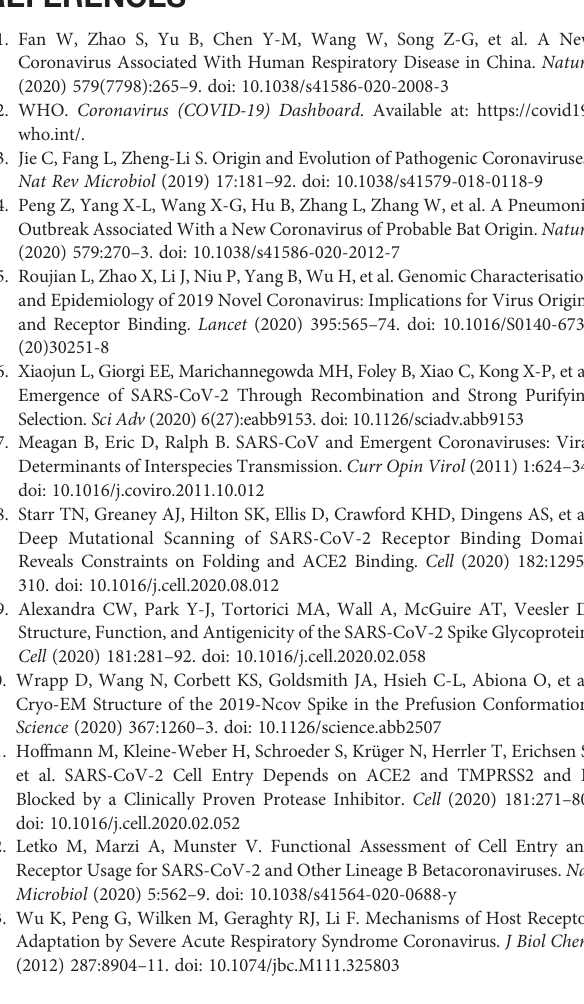
Supplementary Figure 3 | Root mean square deviations (RMSD) of the complex S-RBD hACE2 receptor simulation. We report here only one (randomly chosen) of the fi ve trajectory replicas produced for data analysis. All other simulations produce similar results. Supplementary Figure 4 | Details of the interaction of the RT S-RBD and hACE2 receptor. For clarity, the fi gure is split into two different regions, which are spatially separated (A, B) . Lys417 interacts only with Asp30. Tyr449 and Gln498 share an interaction with Asn38 and Gln42 side chains. Leu455 and Phe456 are inside a pocket of charged amino acids and interact with the main chain of Asp30, Lys31, and Thr27. Phe486 is inside a hydrophobic pocket formed by Phe28, Leu79, and Phe83. Asn487 interacts with the polar side chain of Gln24. Gln493 is within a charged pocket and interacts with the side chains of Lys31, Glu35, and His34. Thr500sharesan interactionwiththe polarsidechainofTyr41andthe chargedside chains of Asp355 and Arg357. Asn501 is inside a charged pocket but interacts to some extent with Tyr41 and Lys353. Tyr505 establishes an interaction with Glu35 and Arg393. Supplementary Figure 5 | Maps of the contact between different variants of S- RBD and hACE2 receptor. The x-axis of the matrix represents S-RBD residues, while the y axis represents hACE2 receptor residues. The color represents the probability of interaction along the whole set of trajectories and goes from white (0%) to blue